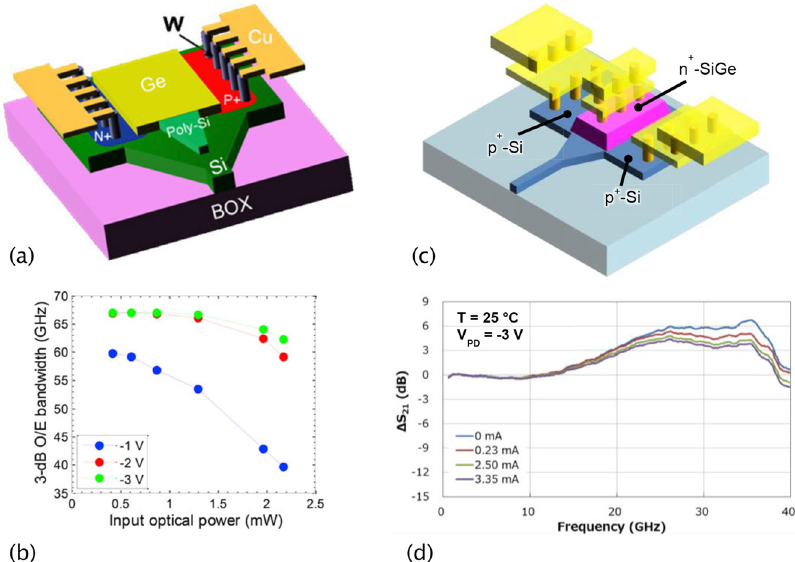
Figure 8: (a) Schematic of a lateral junction Ge-on-Si PD with (b) its 3-dB bandwidth as function of input power at various bias voltages [87]. (c) Schematic of a vertical junction Ge-on-Si PD with (c) its frequency response (measured with a tran- simpedance ampli fi er) at various input output powers